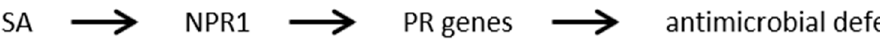
Figure 5. Salicylic acid signal transduction .